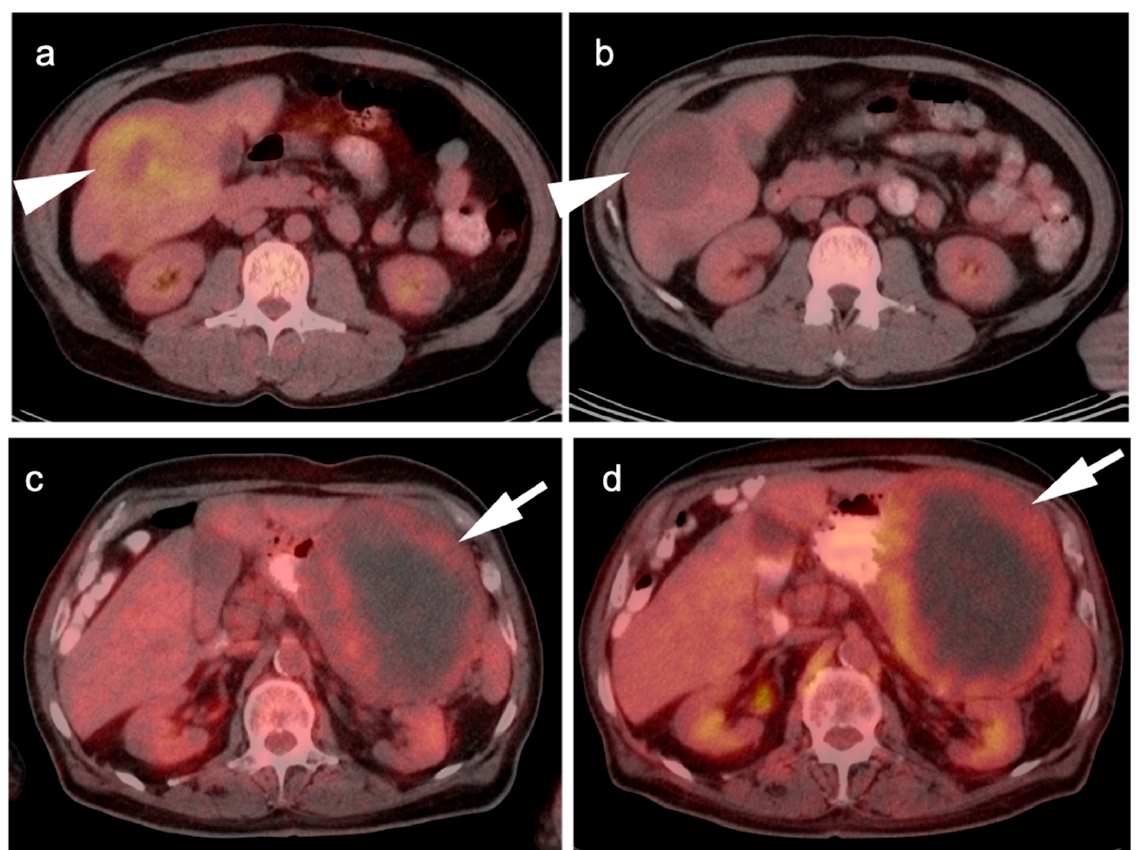
Figure 13. Two cases of GIST tumor. Case 1 ( a,b ): Hepatic GIST metastatic disease before and after successful treatment with Imatinib. ( a ) Pretreatment axial FDG PET-CT shows hypermetabolic mass in the right lobe of the liver (white arrowhead); ( b ) Post treatment axial fused FDG PET-CT image show resolution of metabolic activity with treatment (white arrowhead). Complete metabolic re- sponse means disease control, not complete pathologic response; Case 2 ( c , d ): Large gastric GIST tumor before and after treatment with imatinib. ( a ) Pretreatment axial FDG PET-CT shows a large, centraly necrotic, peripherally hypermetabolic tumor arising from the stomach (white arrow); ( b ) Post-treatment axial FDG PET-CT shows that the tumor has increased both in size and metabolic activity (white arrow), consistent with lack of tumor control.